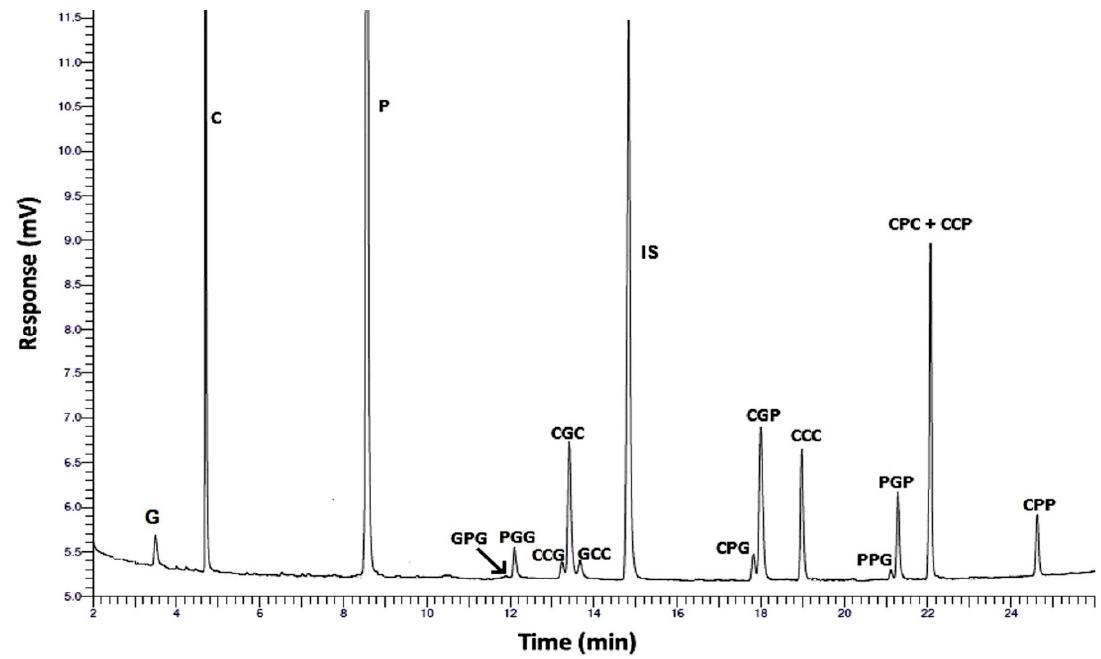
Figure 6. Chromatogram of a reaction sample obtained at 6 h reaction during the esterification of dicaprin and palmitic acid. The experimental conditions were as follows: dicaprin = 32 mg, R M = 3 mol/mol, temperature = 40 °C and biocatalyst load = 150 mg. IS: Internal calibration standard.